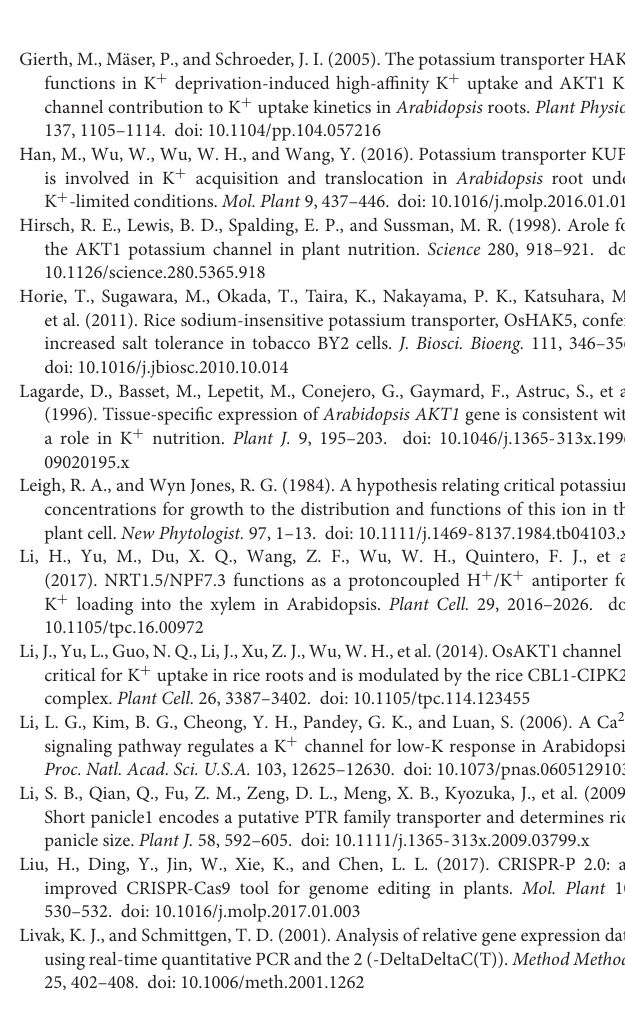
Supplementary Figure 1 | Verification of the Oshak8 mutants. Verification of the Oshak8 mutants by PCR-based sequencing. Two representative transgenic lines (abbreviated as Oshak8-1 and Oshak8-2 , respectively) for Oshak8 mutants are generated from the Nipponbare genetic background. Supplementary Figure 2 | Phenotype analysis of Oshak8 mutants grown in soil. (A) Phenotype analysis of plants grown in soil. (a) Phenotype of plants grown in soil. WT and Oshak8 mutants ( Oshak8-1 , Oshak8-2 ) grown in soil (0.18-mg/g K + ) for 95 days. Bar = 20 cm. (b) Comparison of brown spots, which is a typical K + -deficient symptom of rice on old leaves of plants. Growth conditions were as described in (A) . Oshak8-1 and Oshak8-2 displayed brown spots on old leaves. WT displayed no brown spots on old leaves. Bar = 1 cm. (c) The main panicle lengths of plants. WT and Oshak8 mutants ( Oshak8-1 , Oshak8-2 ) grown in soil (0.18-mg/g K + ) for 105 days. Main panicle lengths were measured. Bars = 8 cm. Data are presented as means ± SD. Bar = 10 cm. (B–E) Statistical analysis of plant heights (B) , main panicle length (C) , seed setting rate (D) , and 1,000-grain weight (E) of plants. Growth conditions were as described in (A) . Significant differences were found between WT and Oshak8 mutants ( Oshak8-1 , Oshak8-2 ) ( ∗ P < 0.01 by Student’s t -test). n ≥ 20 for each data point. Asterisks represent significant differences. Supplementary Figure 3 | Pollen viability analysis of Oshak8 mutants. (A) I 2 -KI staining of pollen grains from the wild type and Oshak8 mutants ( Oshak8-1 , Oshak8-2 ). Bar = 100 µ m. (B) Pollen viability of the wild-type and Oshak8 mutants ( Oshak8-1 , Oshak8-2 ). The experiment was repeated three times with similar results. Error bars represent ± SD. Significant difference was found between